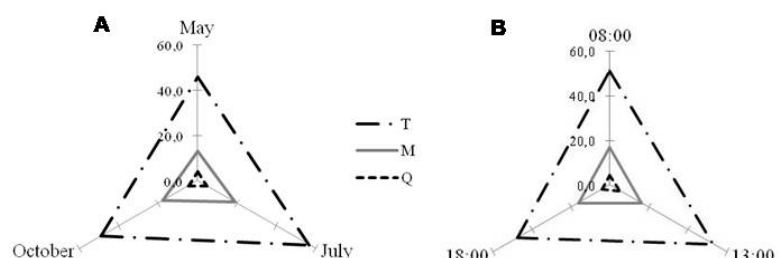
Figure 7. Monthly ( A ) and diurnal ( B ) variation of the di ff erent polyphenolic classes detected in Pistacia lentiscus leaf ethanolic extracts: M—myricetin derivatives; Q—quercetin derivatives, and T—tannin derivatives. For monthly variation ( A ), July seemed to be slightly better to reach higher amounts of T derivatives. While considering the time of the day ( B ), there is not a big difference between the content of the different compounds. Graphics were obtained with the mean values of the consecutive years of analysis (2014 and 2015, n = 18).